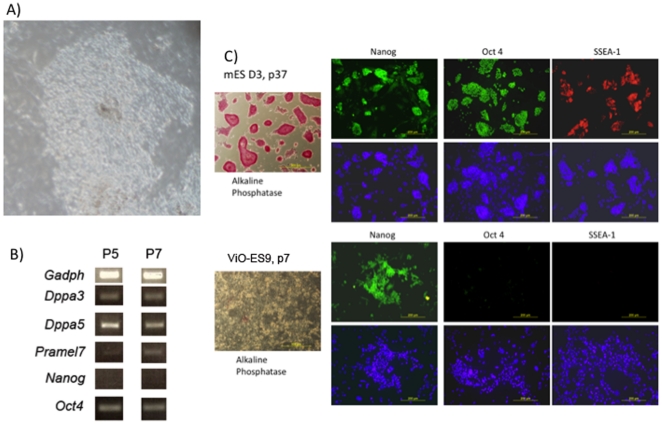
Expression of pluripotent markers in ViO-ES9 cells: ES cell colonies derived from vitrified oocytes (A).RT-PCR amplification of Oct4, Dppa3, Dppa5, Pramel7 and Nanog in ViO-ES9 cells at passage (P) 5 and 7 (B); ViO-ES9 and D3-ES cells were stained with antibodies to OCT-4, SOX-2, SSEA-1 and with alkaline phosphatase. Nuclei are stained with DAPI (blue) (C).